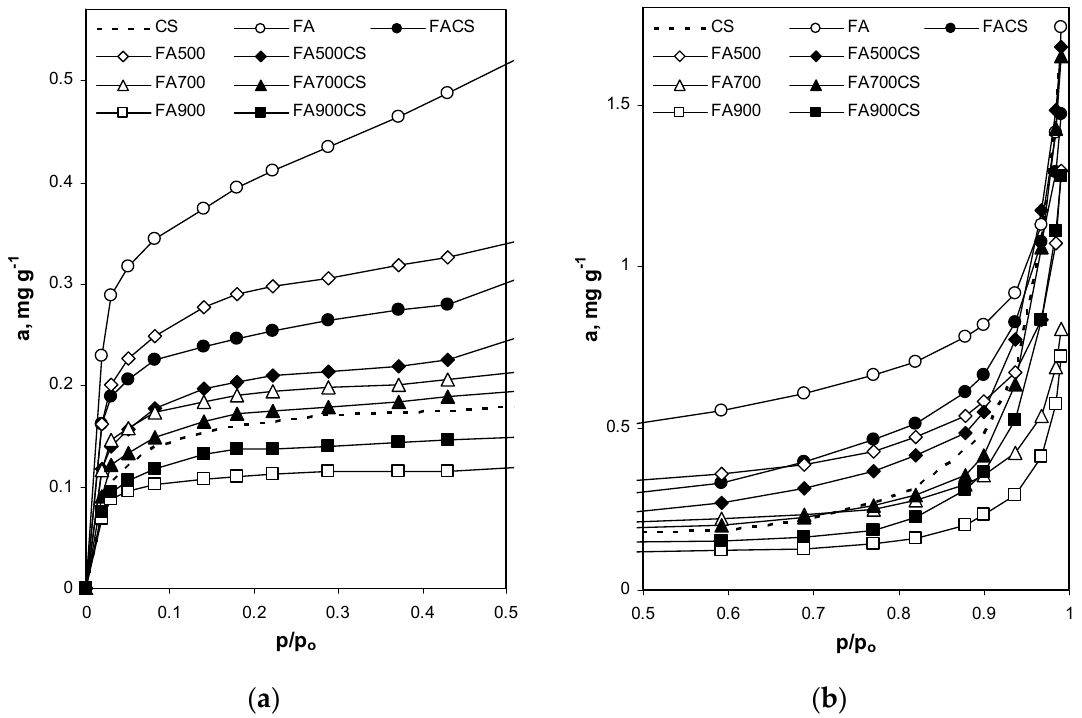
Figure 2. Low temperature nitrogen adsorption isotherms of the studied adsorbents. ( a ) low pressure range; ( b ) high pressure range.